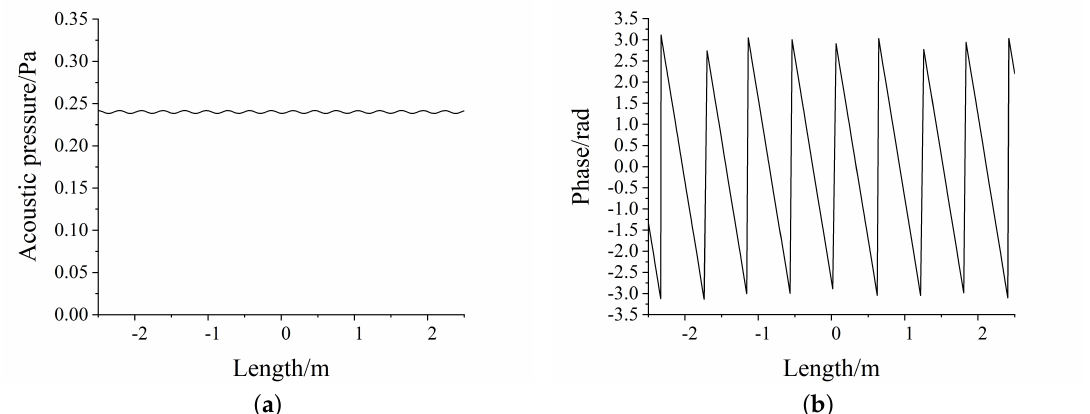
Figure 10. ( a ) The information of sound pressure amplitude in sound tube inner with steel sample at 2500 Hz. ( b ) The information of sound pressure phase in sound tube inner with steel sample at 2500 Hz.